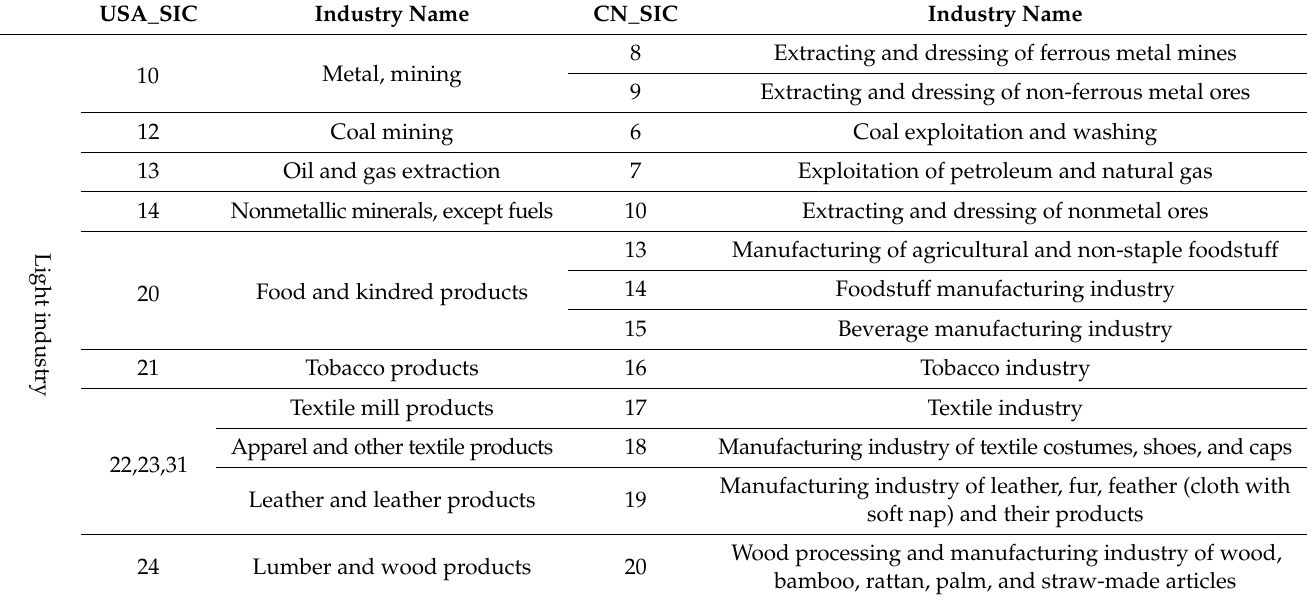
Table 1. Matching of